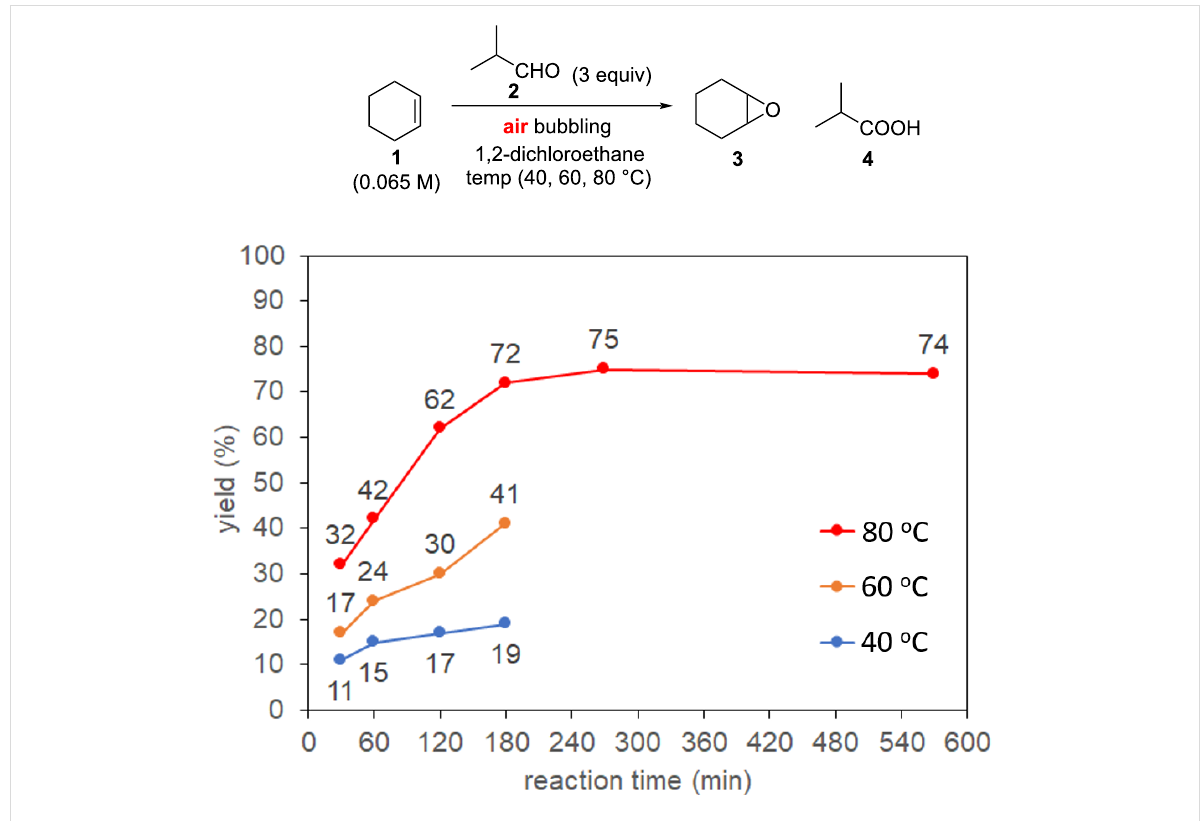
Figure 1: Epoxidation of cyclohexene with air bubbling in batch at various